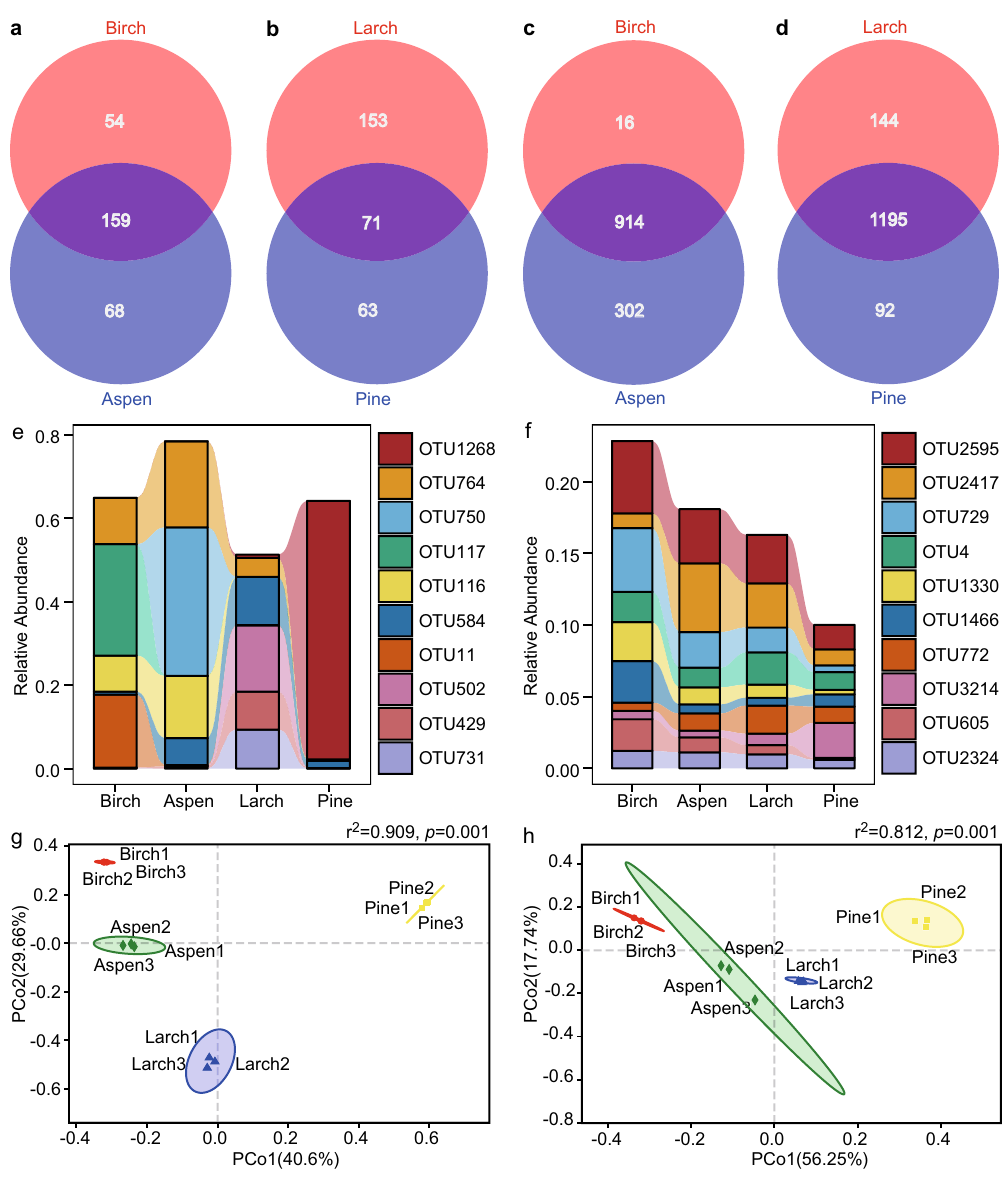
Figure 1. Composition of soil microbial communities at OTU level. Facets a-d are visualizations of Venn analyses: ( a ) soil fungi of birch forest and aspen forest, ( b ) soil fungi of larch forest and pine forest, ( c ) soil bacteria of birch forest and aspen forest, and ( d ) soil bacteria of larch forest and pine forest. Facets e – f are microbial relative abundance bar charts. Bar charts showing relative abundance of top ten abundant soil fungal ( e ) and bacterial ( f ) OTUs. Facets g and h visualized PCoA results of soil ( g ) fungal and ( h ) bacterial communities. Fiducial limit for confidence ellipses was 0.95. The r 2 and p values at the top right corners are PERMANOVA